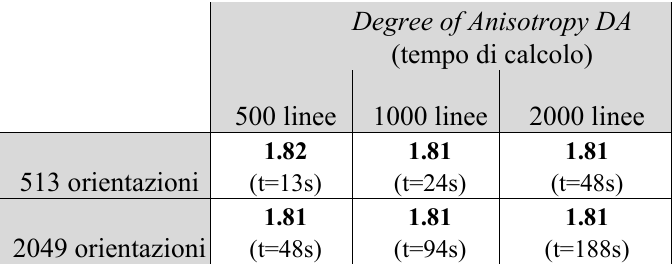
Figura 11: Rappresentazione dei parametri del fabric tensor del MIL in grafici ternari (griglia di misura con 513 orientazioni e 1000 linee).